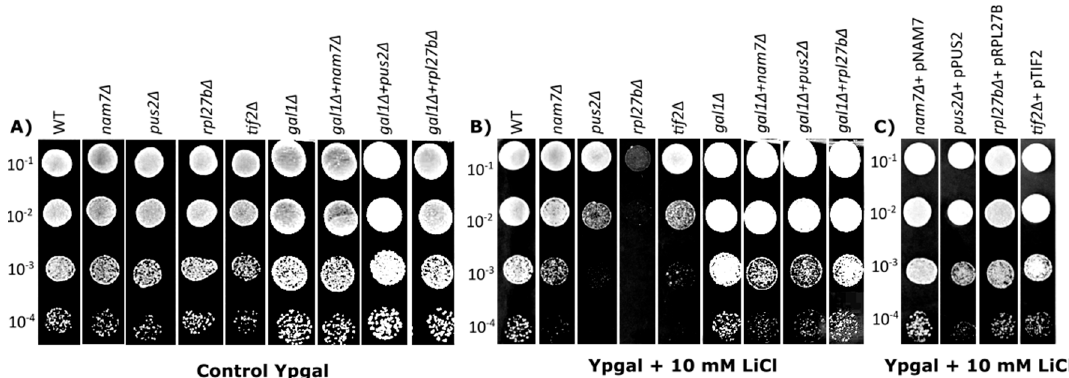
Figure 1. Lithium chloride (LiCl) sensitivity analysis for different yeast strains using spot test analysis. In ( A – C ) yeast cells were serially diluted as indicated (10 − 1 to 10 − 4 ) and spotted on Ypgal (Yeast extract, Peptone, and Galactose) media with or without LiCl (10 mM). In ( A , B ), nam7 ∆ , pus2 ∆ , and rpl27b ∆ show less growth under LiCl treatment compared to wild type (WT). ( C ) Over-expression of target gene in their corresponding deletion mutants reverted cell sensitivity to LiCl (10 mM). Each experiment was repeated at least three times ( n ≥ 3) with similar outcomes.